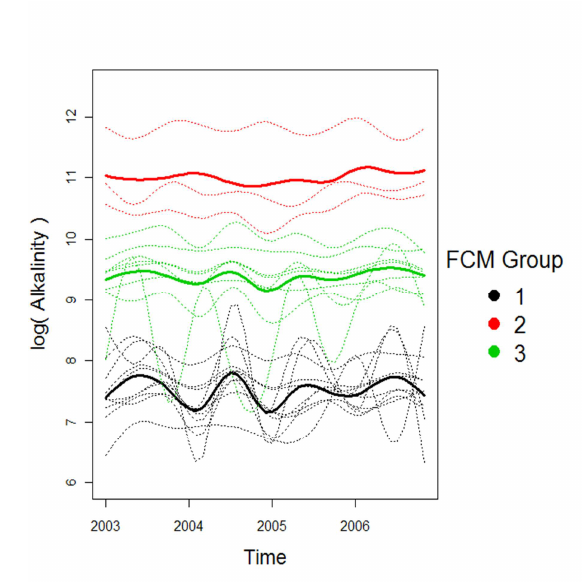
Figure 1 – Group curves and membership of 24 lochs based on alkalinity (Haggarty,